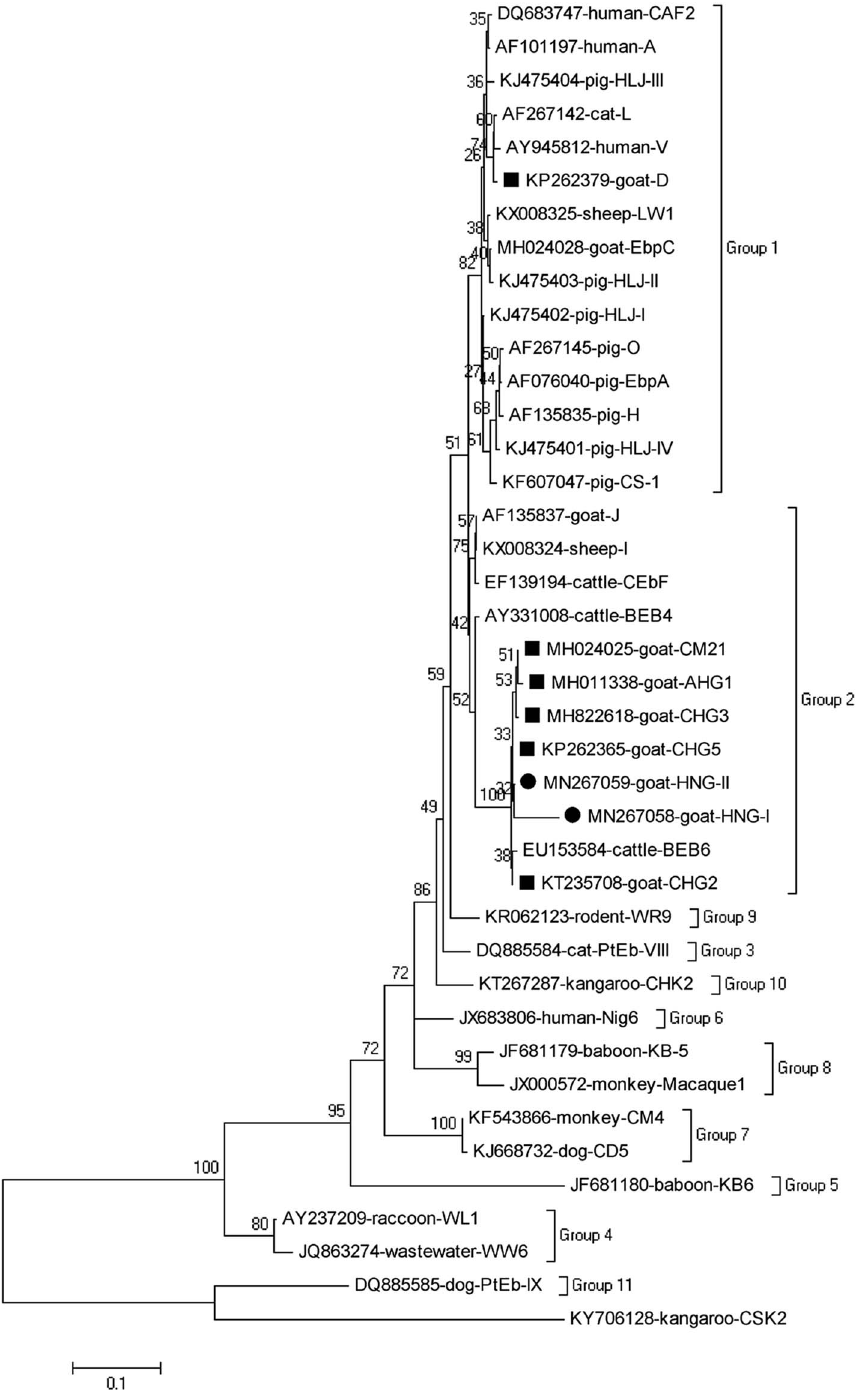
Figure 3. Phylogenetic tree based on the neighbor-joining analysis of ITS sequences. The phylogenetic relationships of E. bieneusi genotypes identi fi ed here and other known genotypes deposited in GenBank were inferred by a neighbor-joining analysis of ITS sequences based on genetic distance by the Kimura 2-parameter model. The numbers on the branches are percent bootstrapping values from 1000 replicates. Each sequence is identi fi ed by its accession number, host origin, and genotype designation. The E. bieneusi genotype CSK2 (KY706128) from white kangaroo was used as the outgroup. The squares and triangles fi lled in black indicate novel and known genotypes identi fi ed in this study,